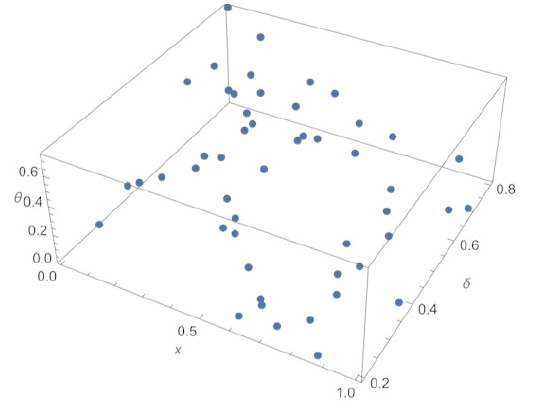
Figure 10. 3-D plot of a training sample for refining parametric PBA-PINN, across parameter space 0.2 < δ <